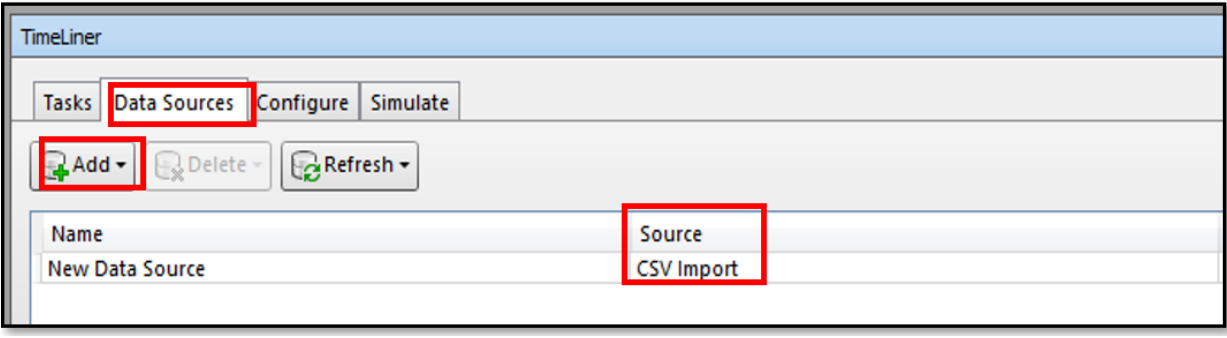
Figure 7. Importing the .csv file to the Navisworks software.